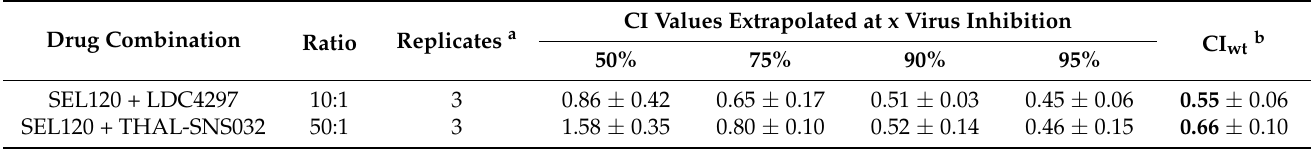
Table 4. Combinatorial anti-HCMV drug assessment using the Loewe additivity fixed-dose assay.